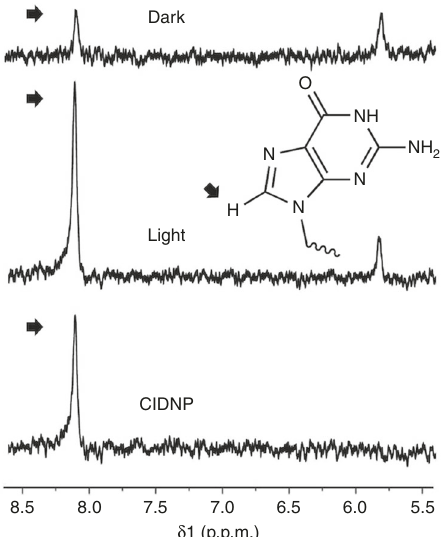
Fig. 2 Photo-CIDNP effects on nucleotides. The H8 proton (black arrow) of guanosine mononucleotide (GMP) experiences a strong absorptive signal enhancement upon irradiation in the presence of fl avin mononucleotide (FMN). Top: dark spectra. Middle: irradiated spectra. Bottom: CIDNP spectra, shown as the difference (light minus dark). The concentrations were 20 mM GMP and 0.5 mM